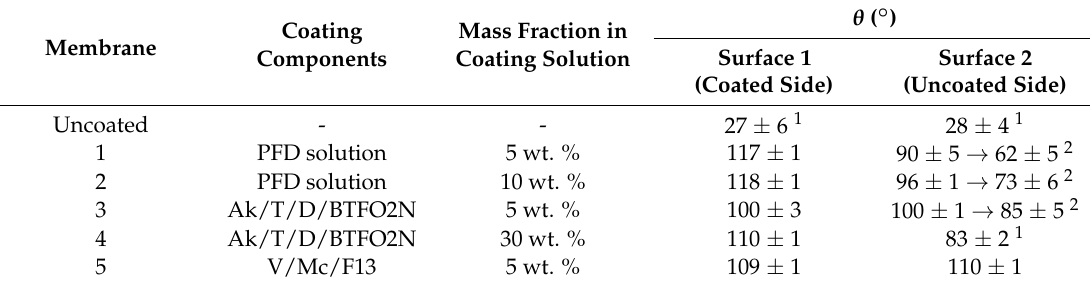
Table 5. Contact